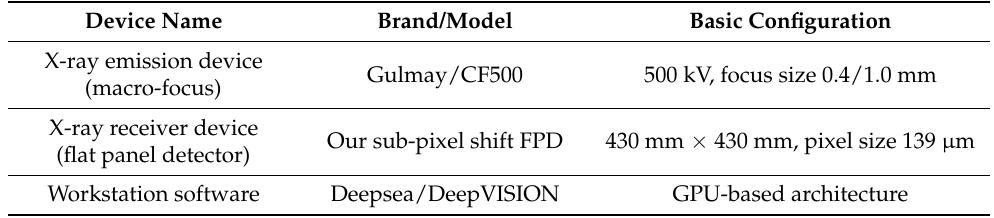
Table 7. Test results of the basic spatial detector resolution SR detector